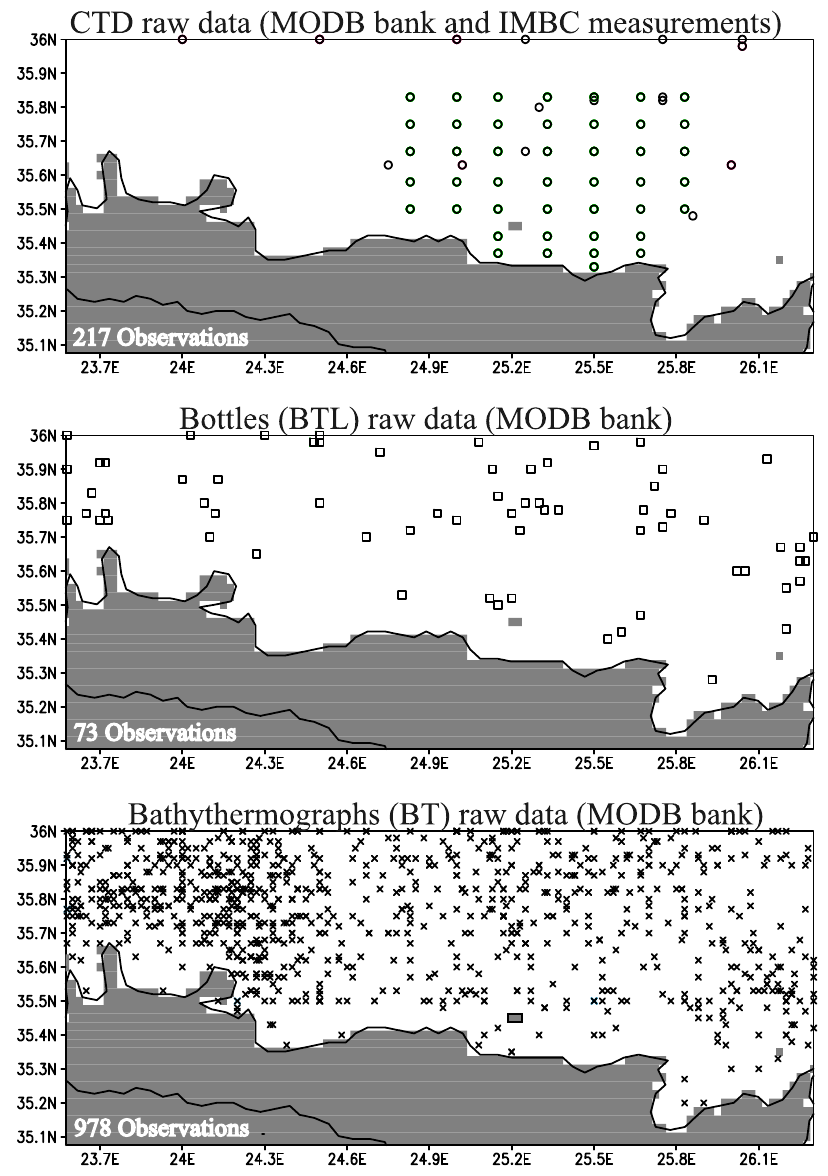
Fig. 2. Spatial distribution of (a) CTDs, (b) Bottles, and (c) Bathythermographs in the modelling